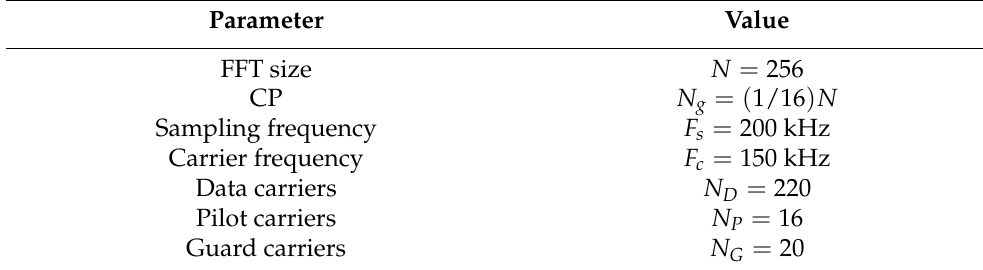
Table 3. OFDM System Parameters.